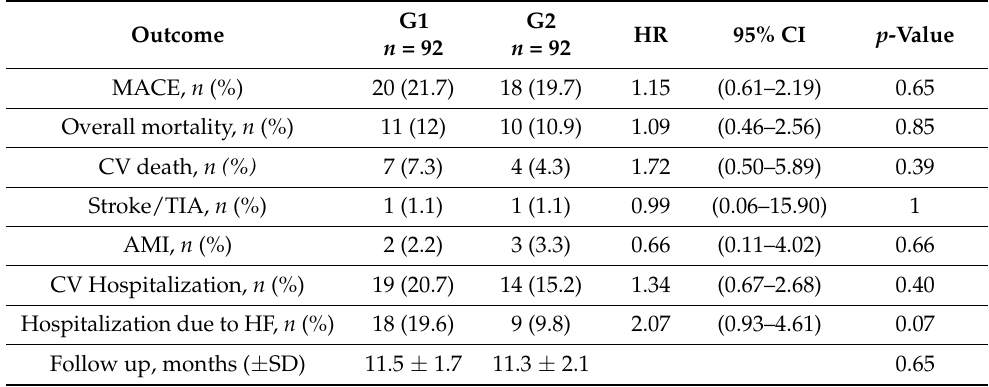
Table 3. Adverse cardiovascular events during the follow up period.